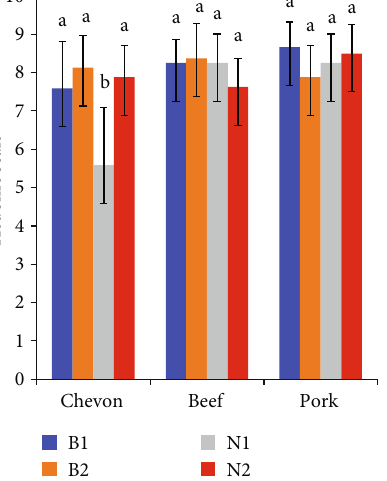
Figure 2: Tenderness (a), fl avor (b), and juiciness (c) of sausages based on the evaluation in the blind and nonblind sensory analyses. a,b Means that are di ff erent on the same sausage indicate signi fi cant di ff erences ( P < 0 : 05 ). B1=South Africans in blind sensory analysis; B2=non-South Africans in blind sensory analysis; N1 =South Africans in nonblind sensory analysis; N2 =non-South Africans in nonblind sensory analysis. ∗ 9-point hedonic scale: 1=dislike extremely, 2=dislike very much, 3 =dislike moderately, 4 =dislike